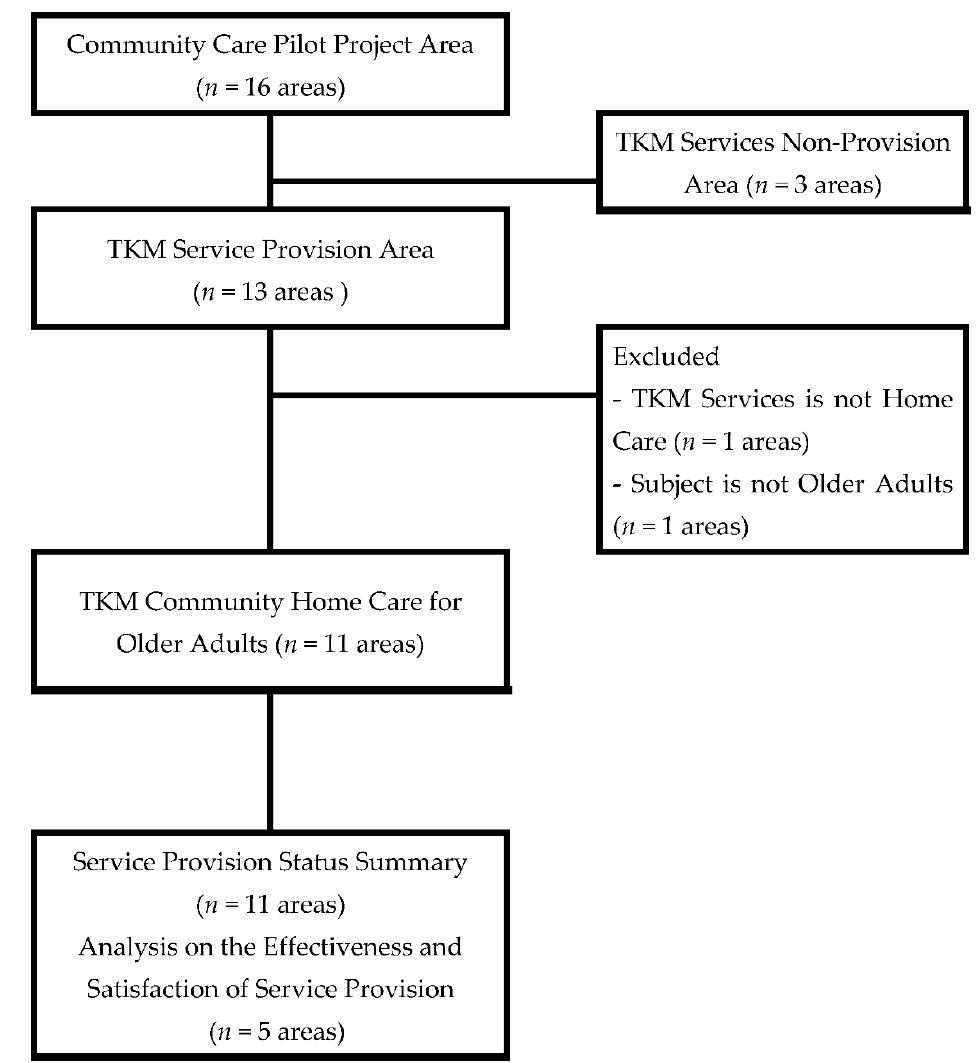
Figure 1. Flow chart of inclusion and exclusion of respondents from survey data.